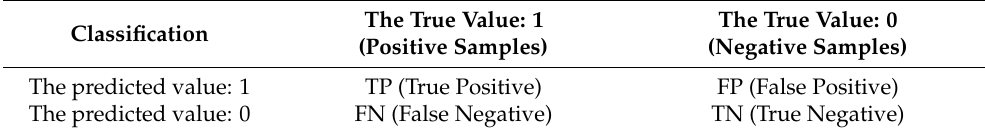
Table 3. Prediction results of the binary classification